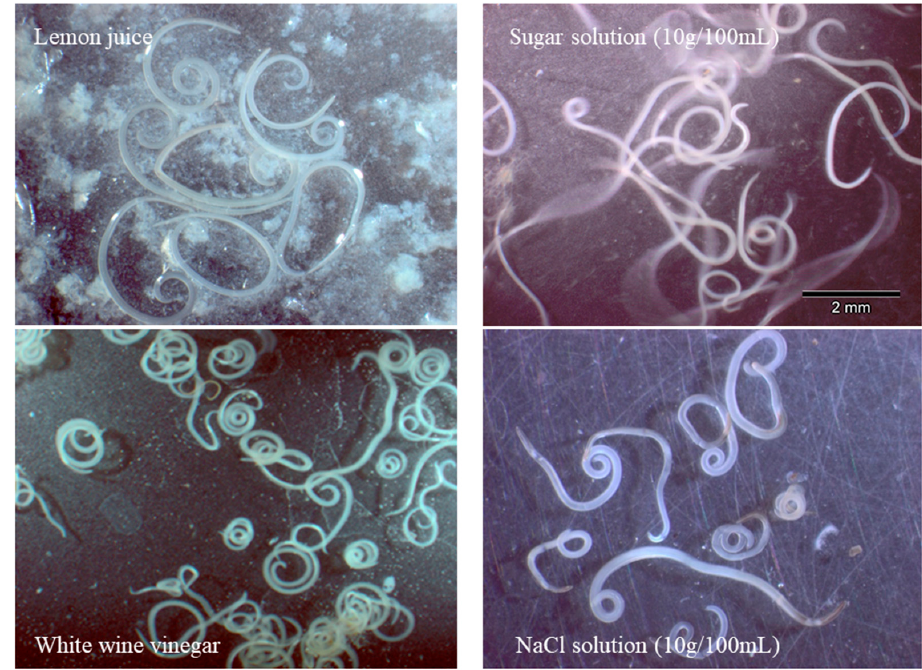
Figure 7. Anisakis spp. larvae exposed directly to (from upper left to right): lemon juice, sugar solution, white wine vinegar, and NaCl solution.